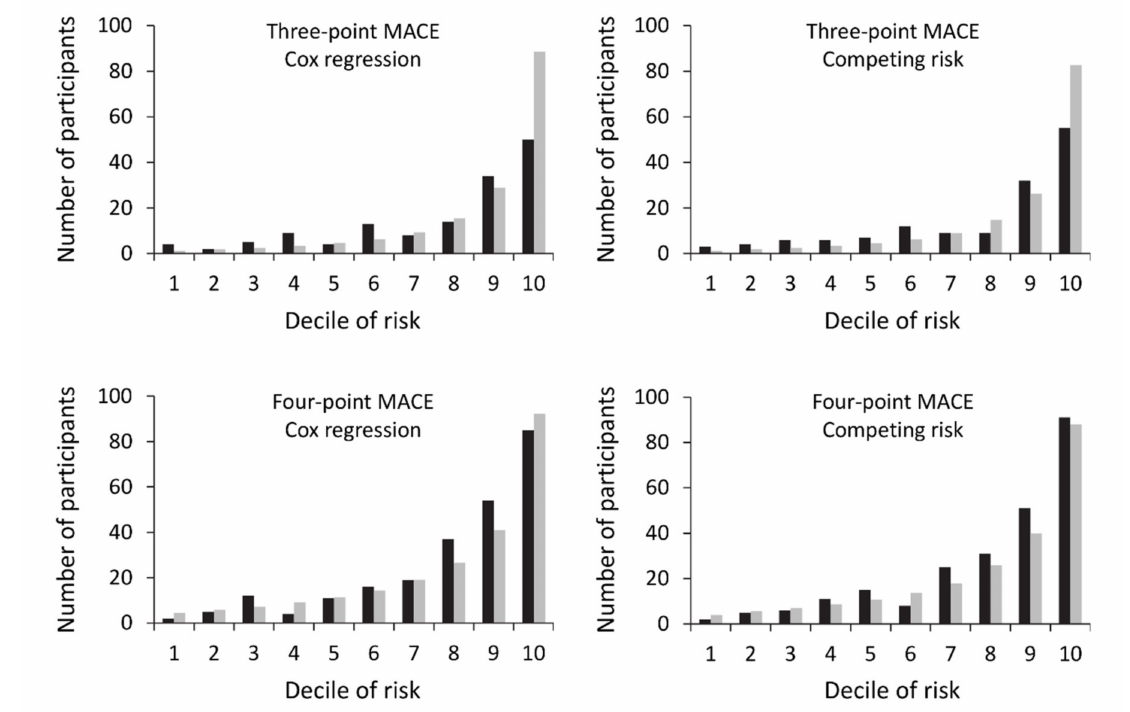
Figure 1. Observed versus predicted numbers of incident first three-point major adverse cardiovascular events (MACE) and four-point MACE by decile of risk in the Fremantle Diabetes Study Phase II type 2 diabetes cohort in Models 1–4. Black bars represent observed events and grey bars represent predicted